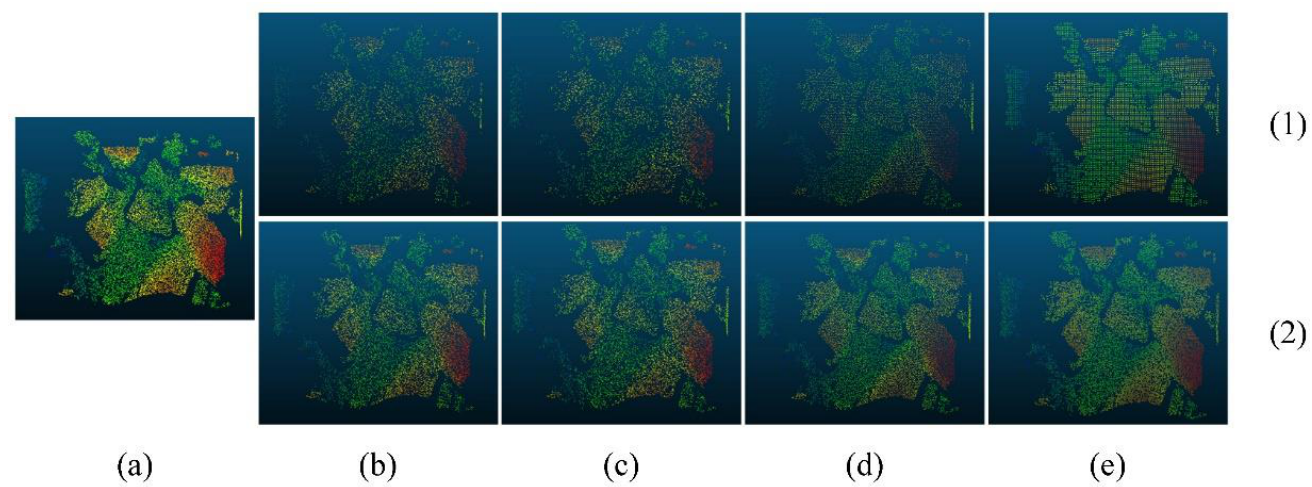
Figure 12. Comparison of simplification effects of different algorithms: ( a ) Raw point cloud; ( b ) Random simplification; ( c ) Curvature simplification; ( d ) Bounding Box Grid; ( e ) PDS.